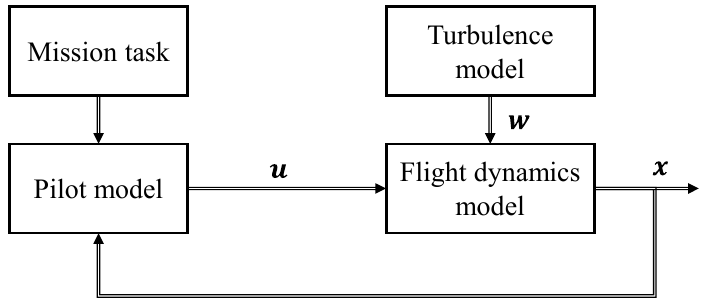
Figure 9. Simulation scheme for rotorcraft maneuvering flight in turbulent wind.